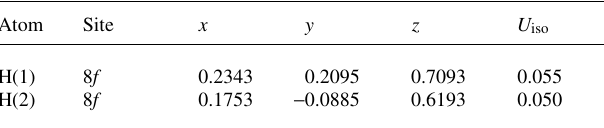
Table 2. Atomic coordinates and displacement parameters (in Å 2 )